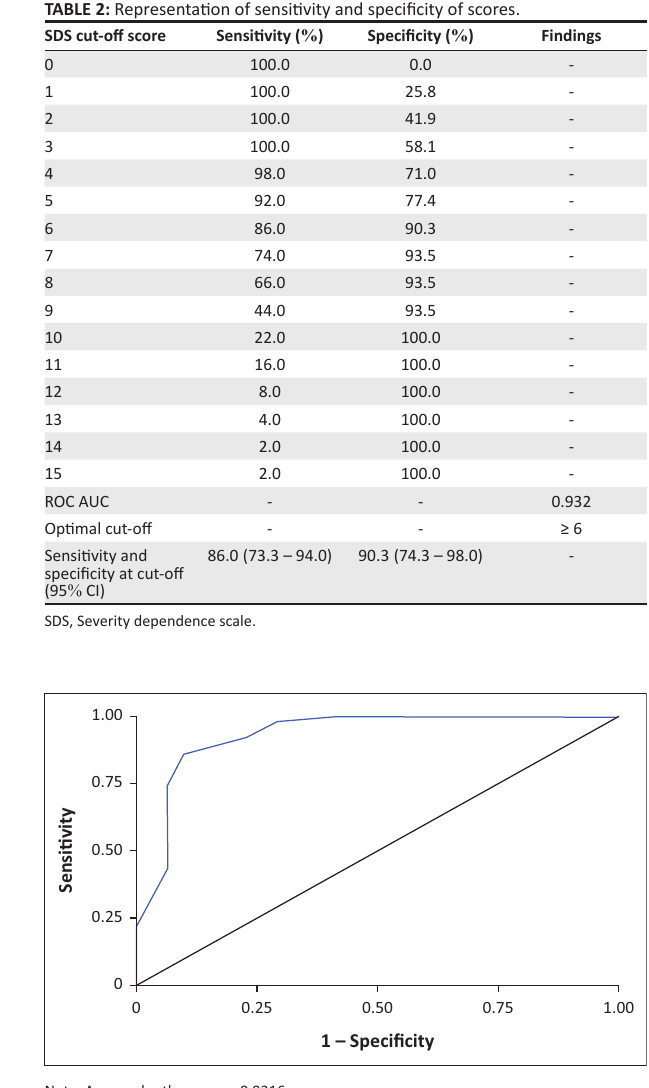
FIGURE 1 : Receiver-operating characteristic curve